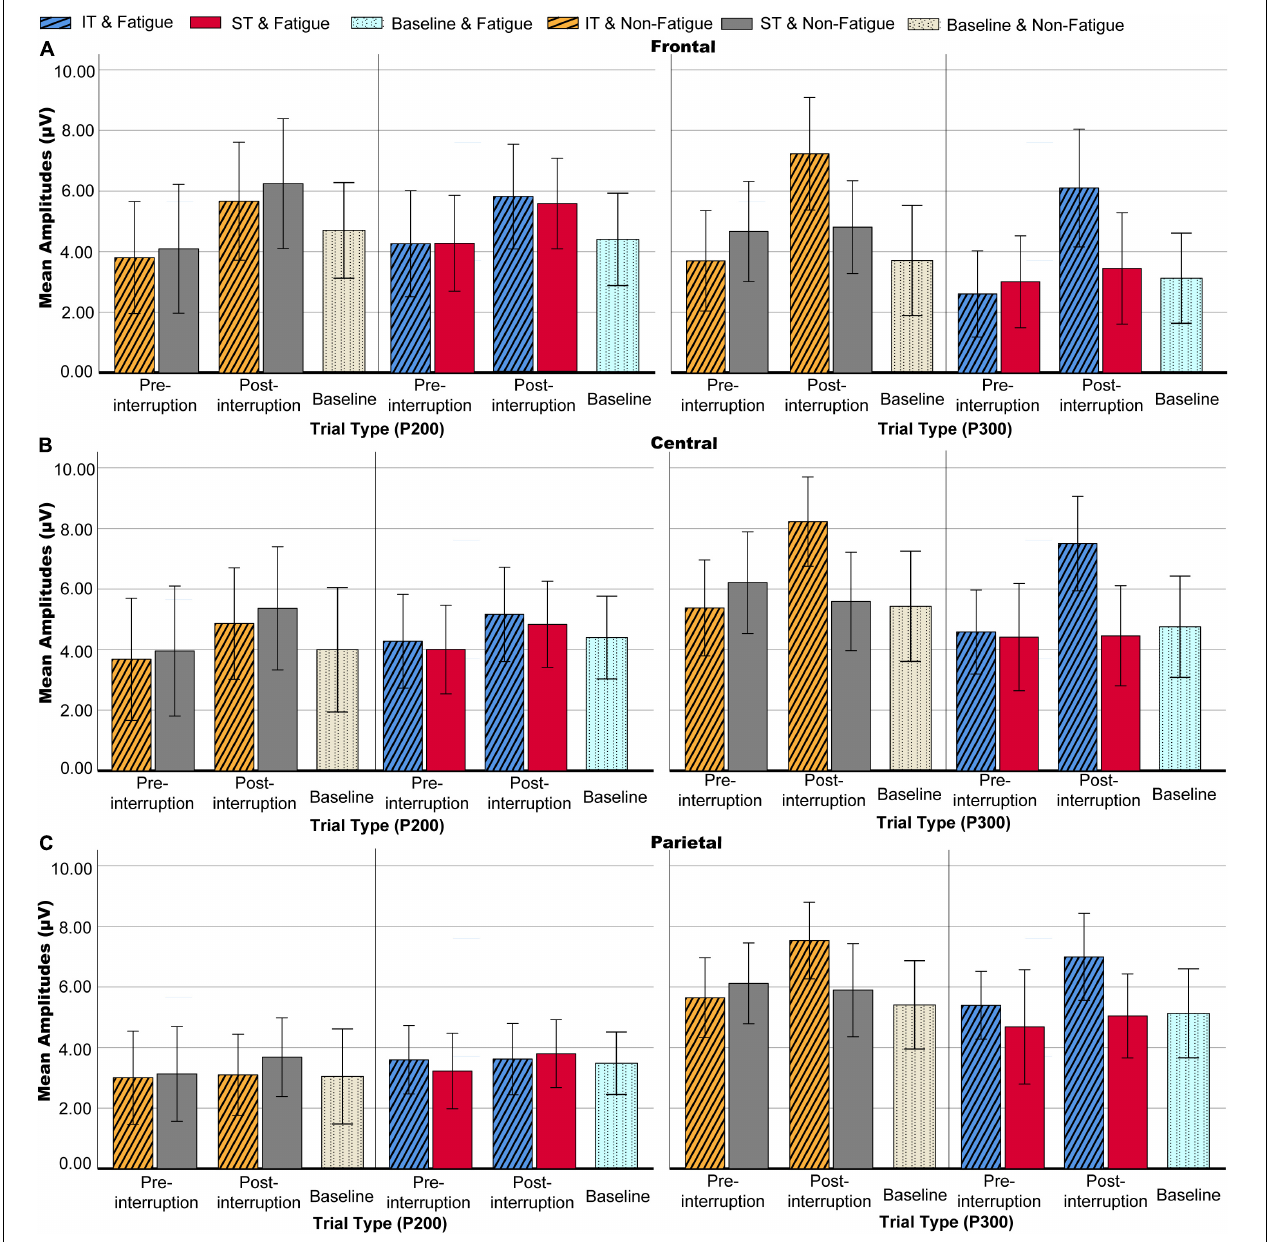
FIGURE 7 | Mean P200 and P300 amplitudes of each condition at electrode sites. (A) Frontal electrodes. (B) Central electrodes. (C) Parietal electrodes. Error bars represent 95% CIs.